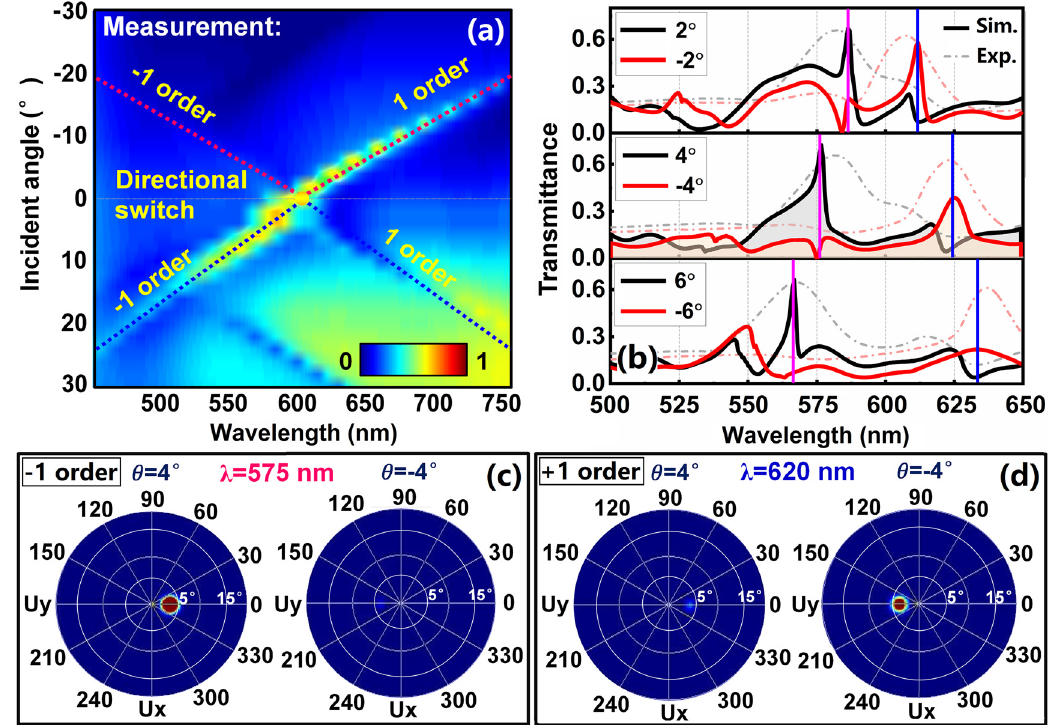
Figure 6: Measurement and calculated optical results of the bimetallic color routing in the transmission direction. (a) Measurement results of three-dimensional distribution of transmittance optical spectra as a function of wavelength and incident angles. (b)Simulatedandexperimentaltransmittancespectraofthebimetallicmetagratingtunedfrom − 6to6 ° .(c)Simulatedfar- fi elddistributionsof the bimetallic color routing in transmission direction at incident angles of θ = 4 ° and − 4 ° and with the wavelengths of λ = 575 and 620